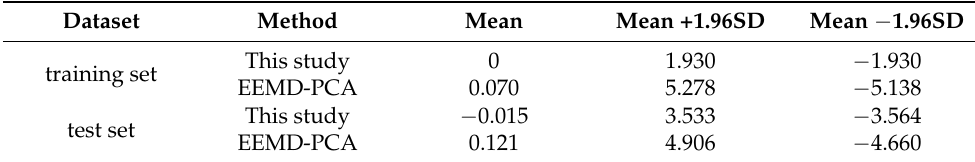
Table 2. Mean of the differences, and the upper and lower limits of the 95% consistency limits for the RR M and RR P with the RR I in the training set and test